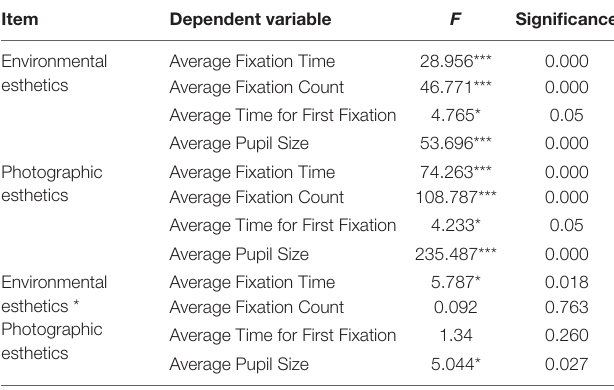
TABLE 2 | ANOVA results: eye-tracking